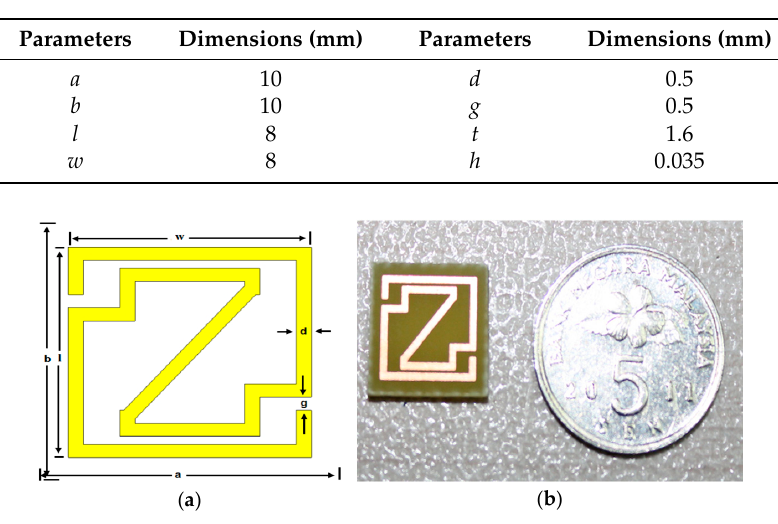
Figure 1. Metamaterial unit cell: ( a ) proposed geometry; ( b ) fabricated geometry.